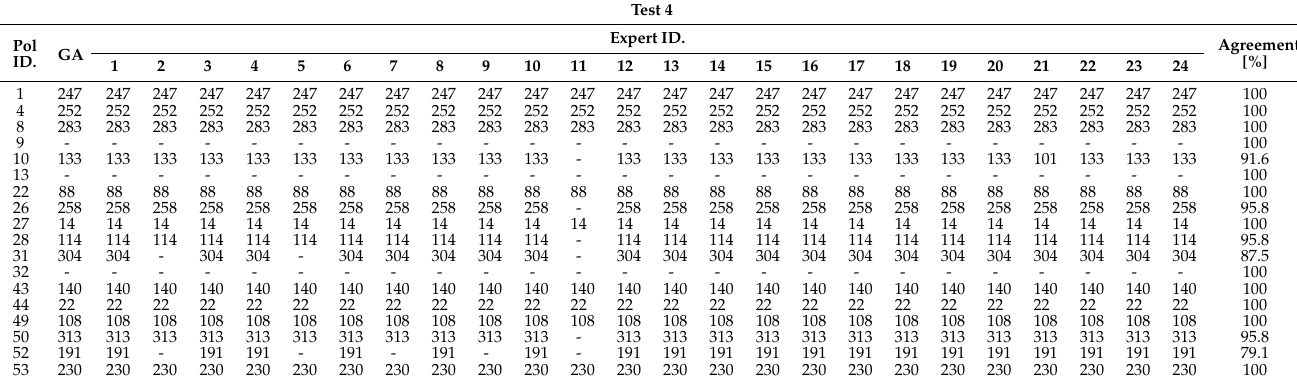
Table A6. Results provided by the experts vs GA. Matching experiment (Test